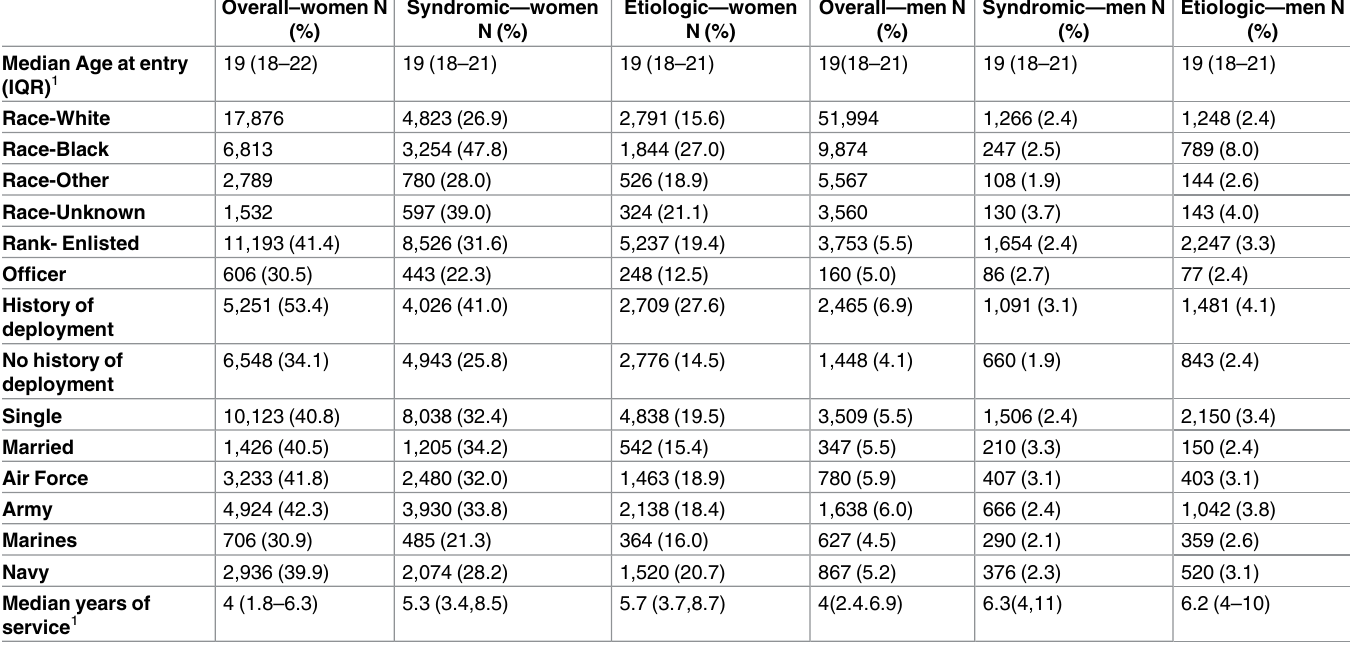
Table 2. Baseline characteristics of participants and lifetime prevalenceof at least one sexually transmitted